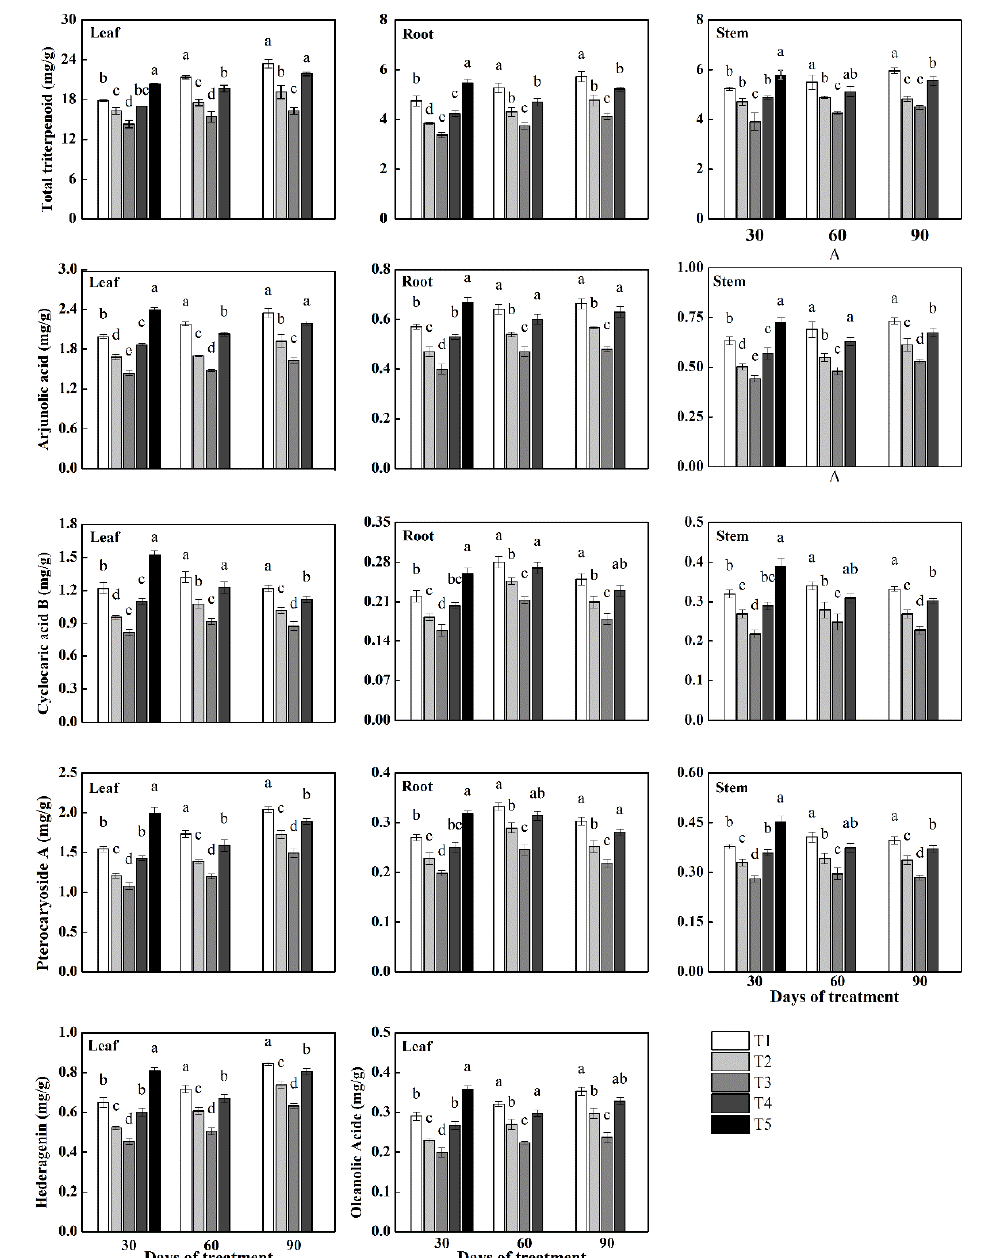
Figure 4. E ff ects of NO 3 − / NH 4 + ratio on the contents of total triterpenoid and five individual triterpenoids in di ff erent components of C. paliurus seedlings sampled at 30, 60 and 90 days after the treatments. Di ff erent letters indicate significant di ff erences among di ff erent NO 3 − / NH 4 + ratio treatments for the same category according to Tukey’s test ( p < 0.05). All C. paliurus seedlings had died at 52 days after the treatment in T5.